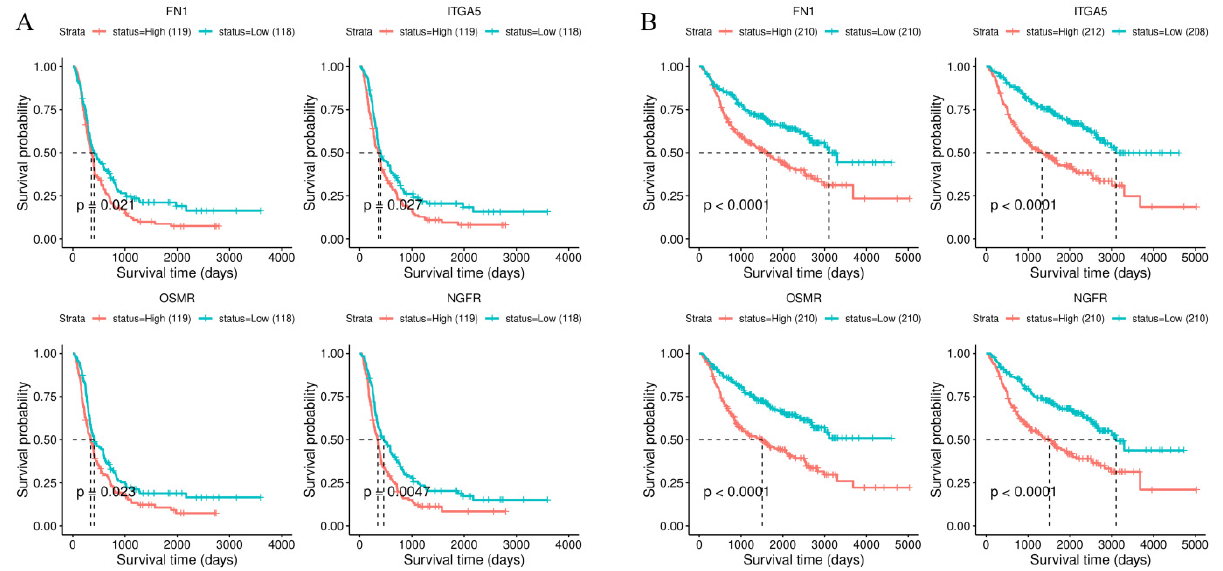
Figure 5. Figure 5. Kaplan–Meier curves of common stiffness − dependent prognostic genes in ( A ) ( A ) CGGA − GBM and ( B ) CGGA − LGG. CGGA − GBM and ( B ) CGGA − LGG.